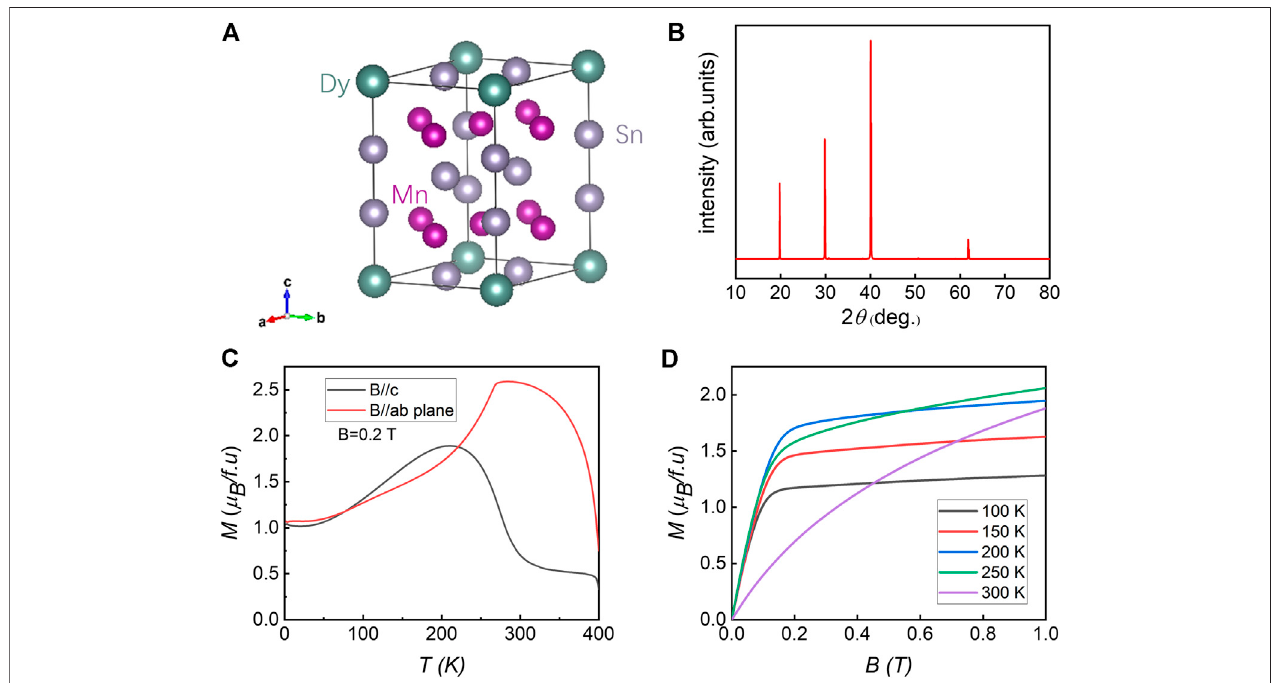
FIGURE1|(A) CrystalstructureofDyMn 6 Sn 6 . (B) XRDpatternofaDyMn 6 Sn 6 singlecrystal. (C) Temperature-dependentmagnetization(M – T)curvewith B // c and B // ab plane. (D) Magnetic fi eld-dependent magnetization (M – H) curve with B //